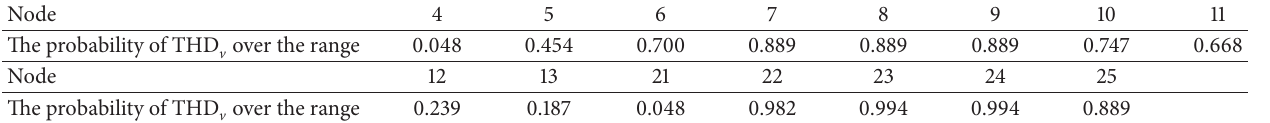
Table 9: The detailed information of THD V over the range when penetration rate is 30%.